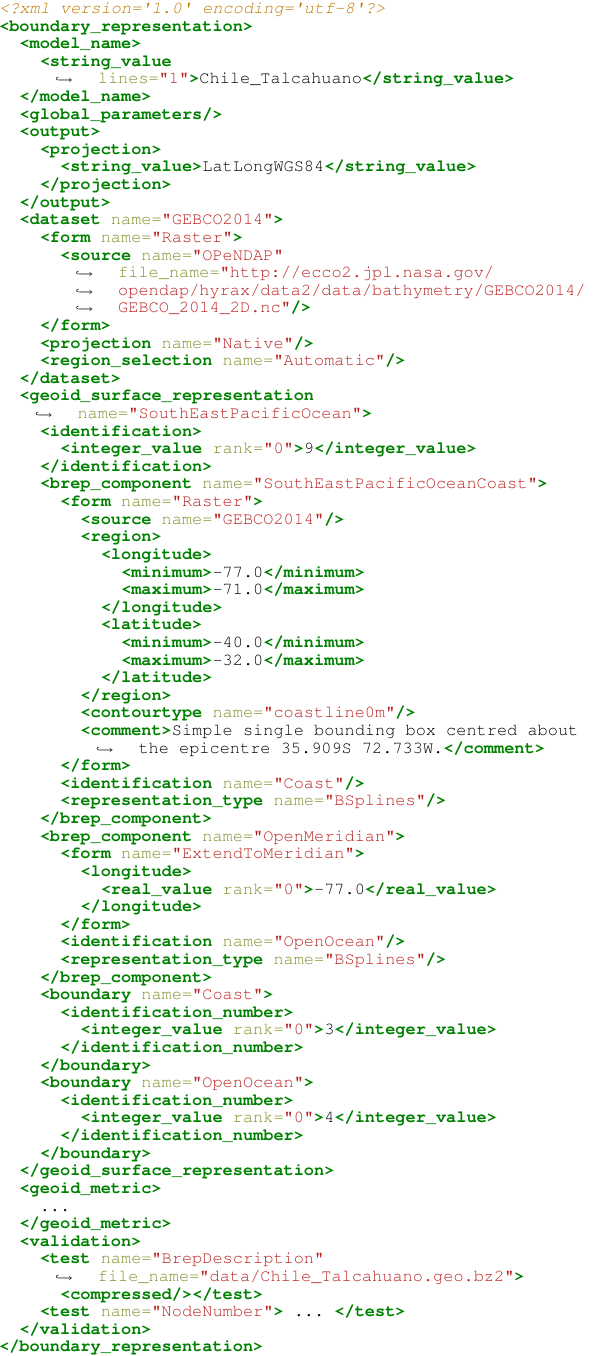
Figure 5. Example domain discretisation specification, in a self- describing BRML file (with a few parts marked ...skipped). This is a human-readable translation of the simple description ( ∗ ) under the formal grammar of the schema that defines the geophysical domain discretisation constraint space. This file is examined by the GUI in Fig. 4 and, on straightforward and automated processing by Shingle, produces the simulation-ready spatial discretisation of Fig.